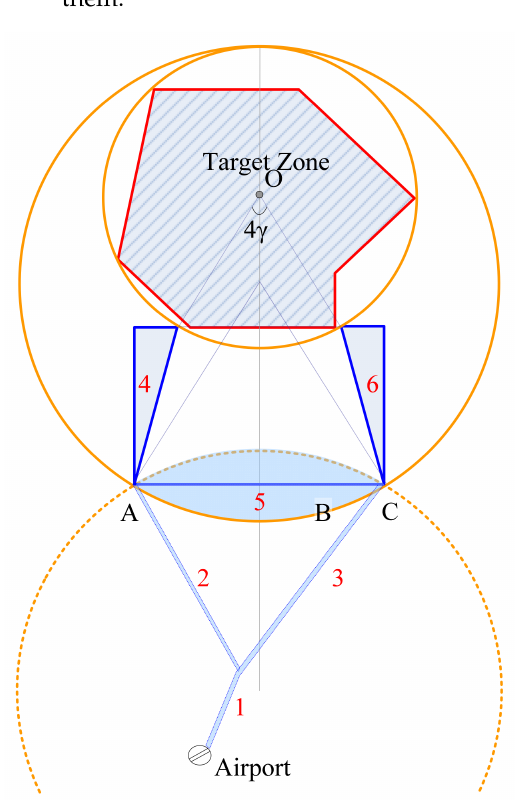
Figure 7. Optimal airspace distribution in time difference localization (Airspaces 4 and